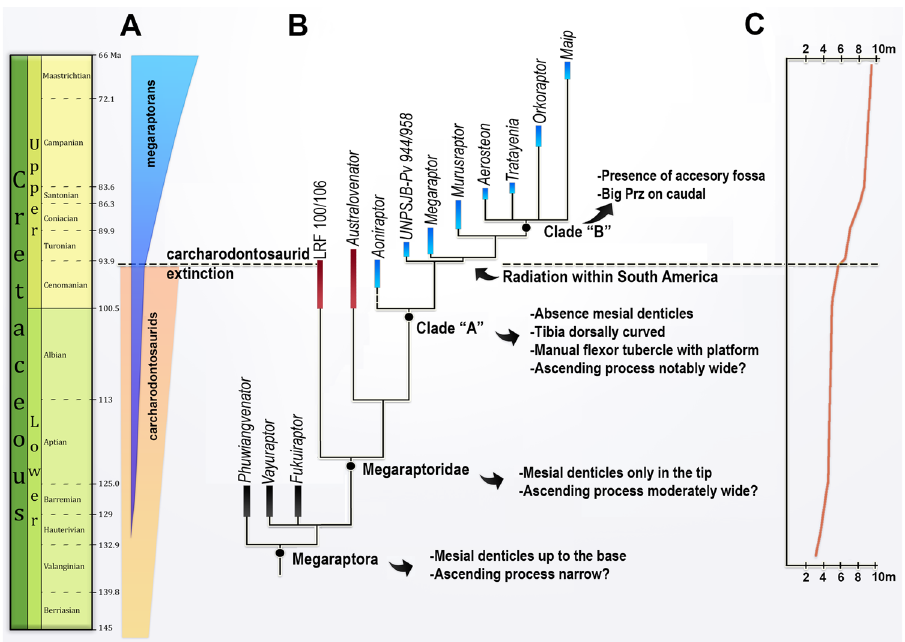
Figure 18. Evolutionary trends of Megaraptora. ( A ) Temporal scale and bars depicting currently known temporal distributions of Megaraptora and Carcharodontosauridae. ( B ) Time-calibrated phylogeny of megaraptoran taxa, showing most relevant genera from Asia (black bars), Australia (red bars) and South America (blue bars). Main synapomorphies supporting each node are indicated by arrows. Tree topology follows the results of the present work. ( C ) Curve showing the increasing in average body size of megaraptorans during Barremian through Maastrichtian time